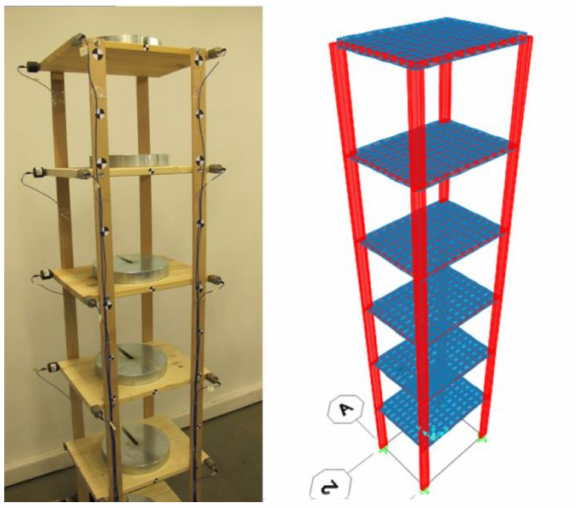
Figure 14. Building models tested in the lab and the corresponding FE